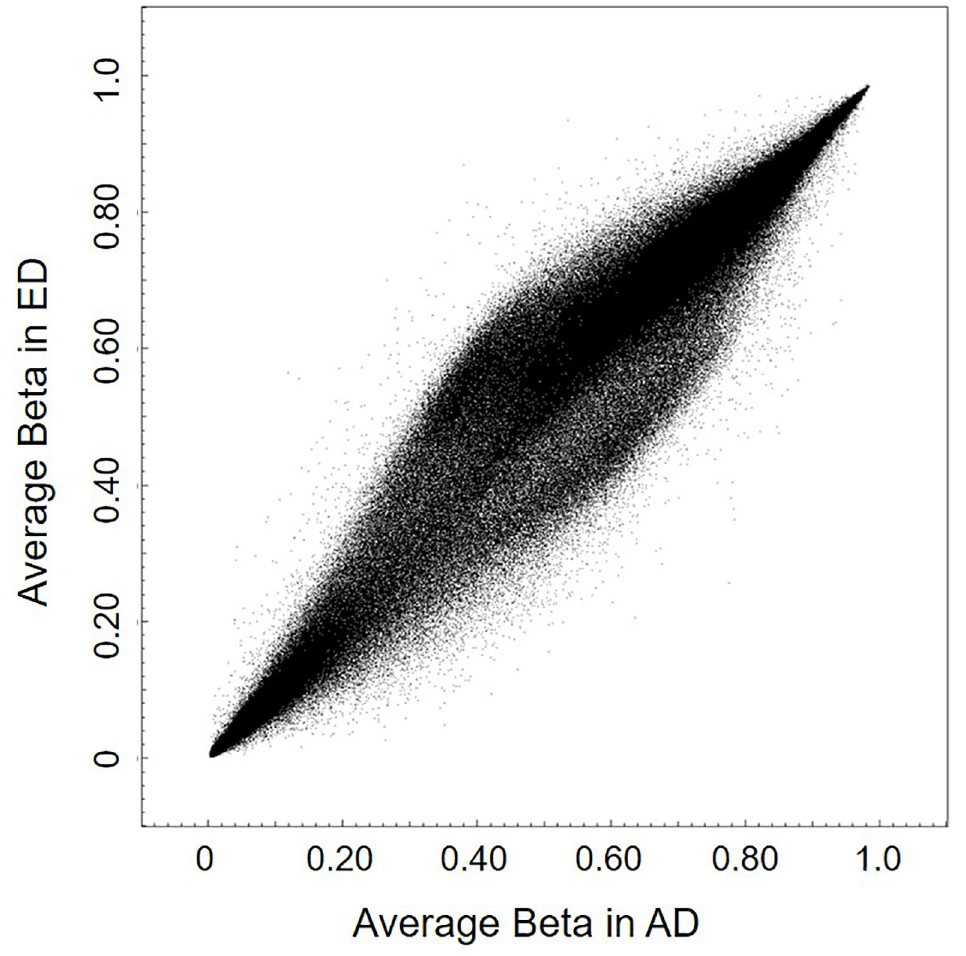
Fig 3. Scatter plot of average DNA methylation level of early stage (ED) and advanced stage (AD) of degeneration.